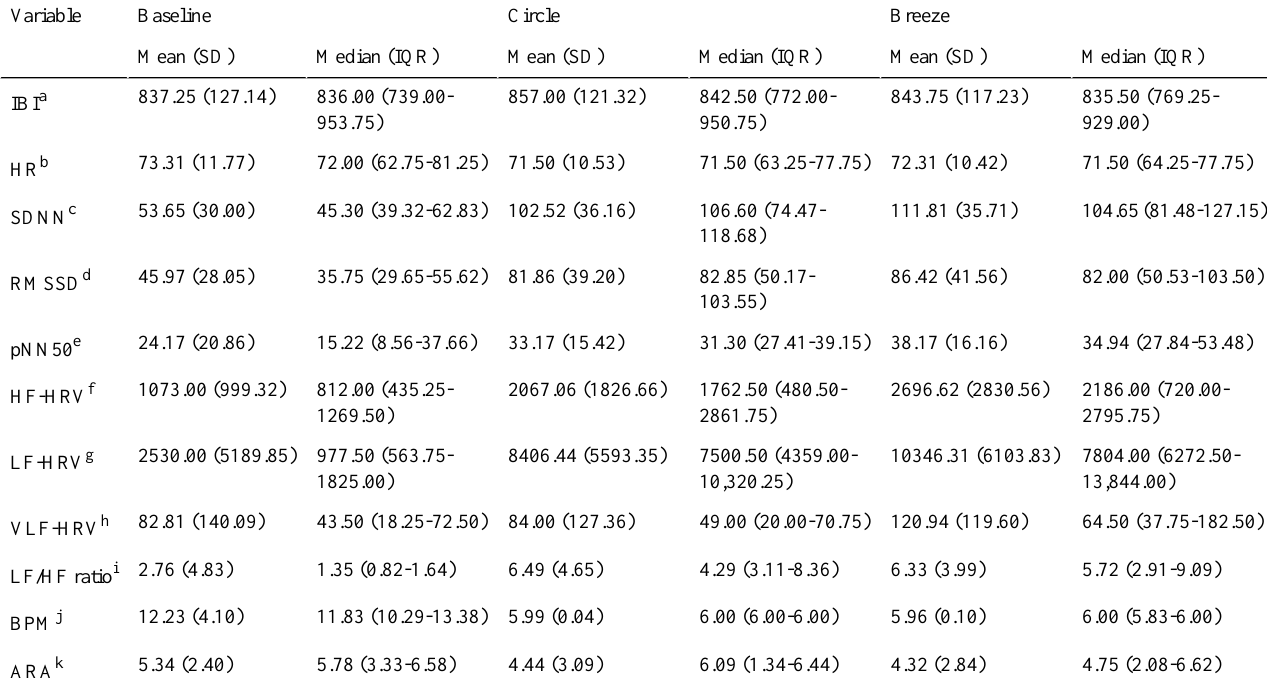
Table 1. Assessment of physiological